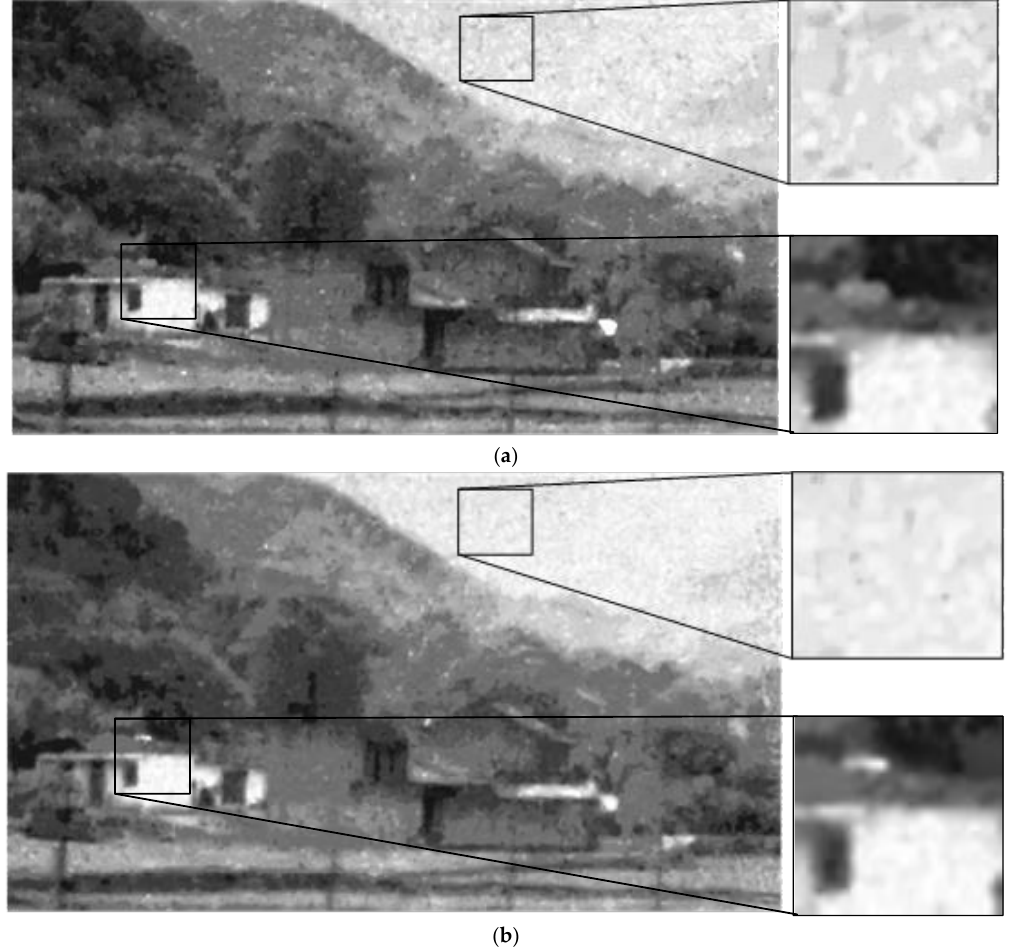
Figure 4. Verify the effectiveness of the hypergraph cut. ( a ) the filtering result based on spectral clustering; ( b ) the filtering result based on the hypergraph cut.